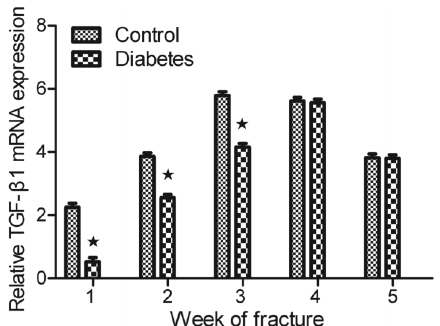
Figure 7. Fluorogenic quantitative polymerase chain reaction results of bone morphogenetic protein-2 (BMP-2) mRNA expres- sion in the two groups. BMP-2 mRNA expression in the diabetes group was lower than in the control group at postoperative weeks 1, 2, 3 (*P o 0.05, t -test). BMP-2 expression achieved its highest level at week 3 in the diabetes group, but reached its highest level at week 2 in the control